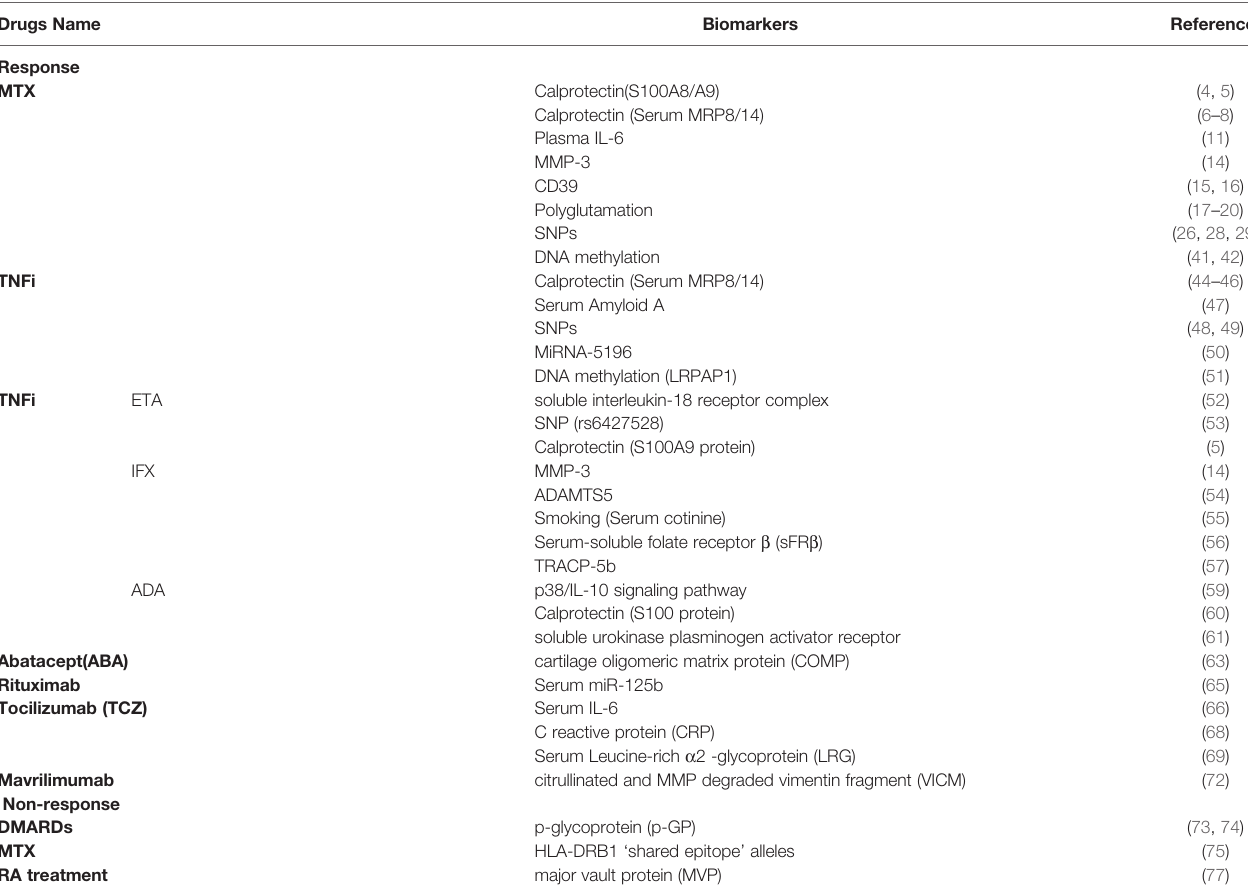
TABLE 1 | The Potential Biomarkers to Predict DMARDs Ef fi cacy and Adverse Effect in